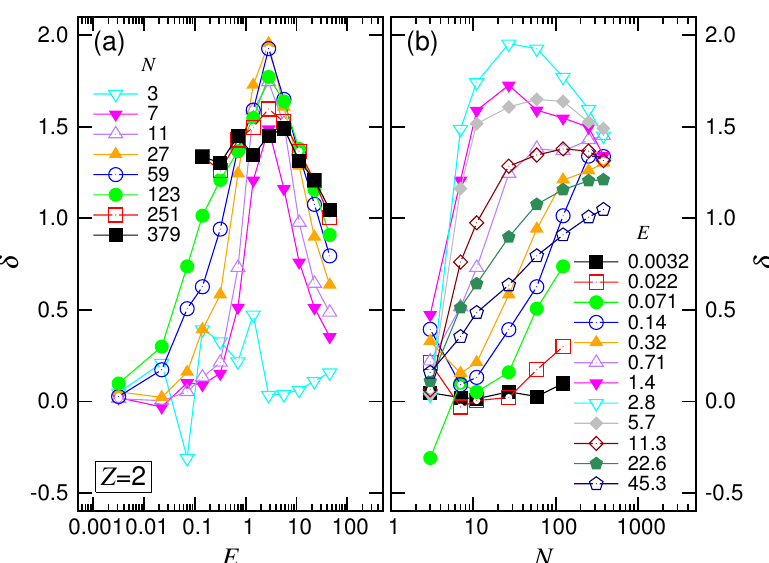
Figure 10. Exponent δ ( a ) as a function of E at different N and ( b ) as a function of N for different E , in the divalent salt solution. The values of E in the plots are the geometric means of the pairs of the adjacent driving field strengths in the legend of Figure 9.